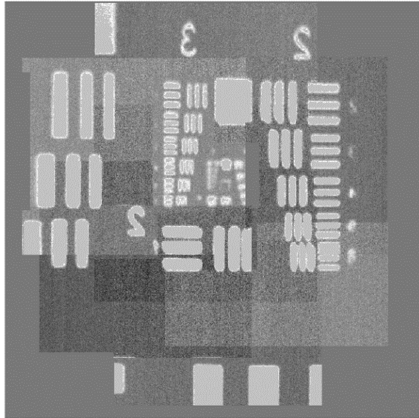
Figure 8. Stitched high-resolution image. Table 1. Parameters of micro-scanning and direct imaging in the